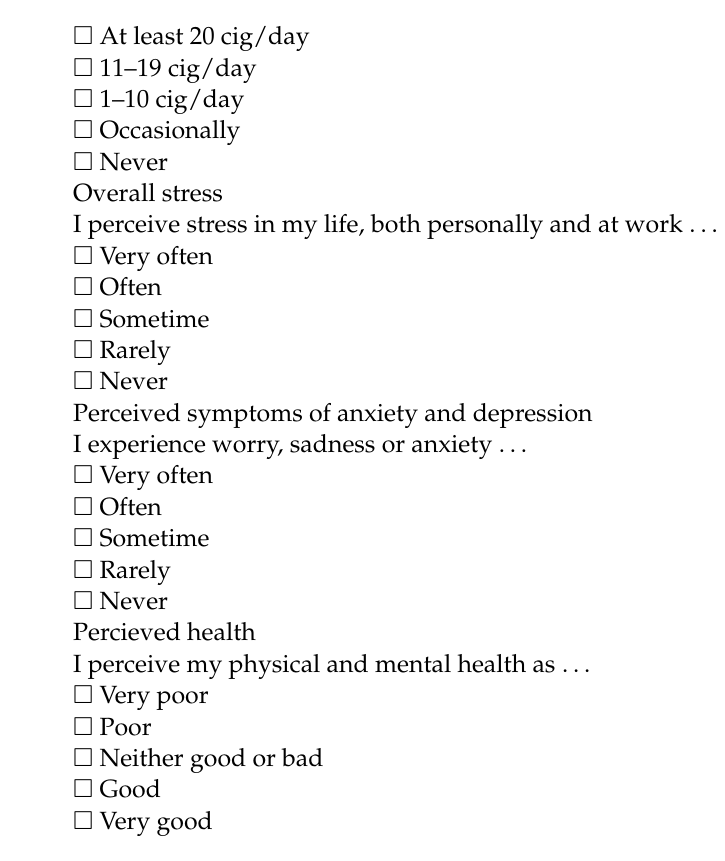
Table A1. Characteristics of participants with COVID-data and/or Health profile assessment-data between 21 April and 2 December in year 2020 ( n = 11,844) and participants with Health profile assessment-data during the same time period in year 2019 ( n =